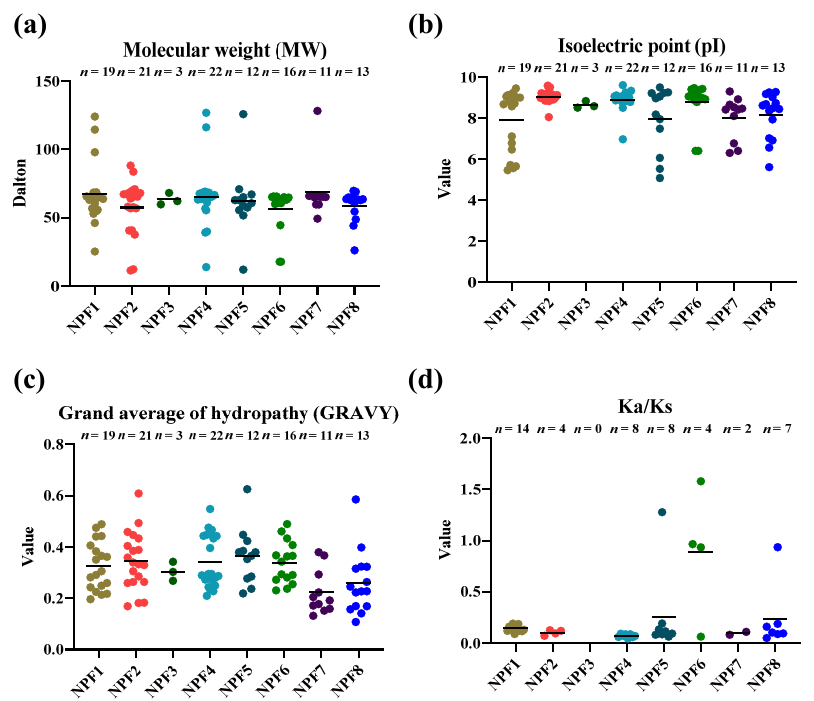
Figure 1. Molecular characterization of the NtNPF proteins in Nicotiana tabacum : ( a ) molecular weight; ( b ) theoretical isoelectric point; ( c ) grand average of hydropathy; ( d ) non-synonymous substitution rate (ka)/synonymous substitution rate (ks) ratios.